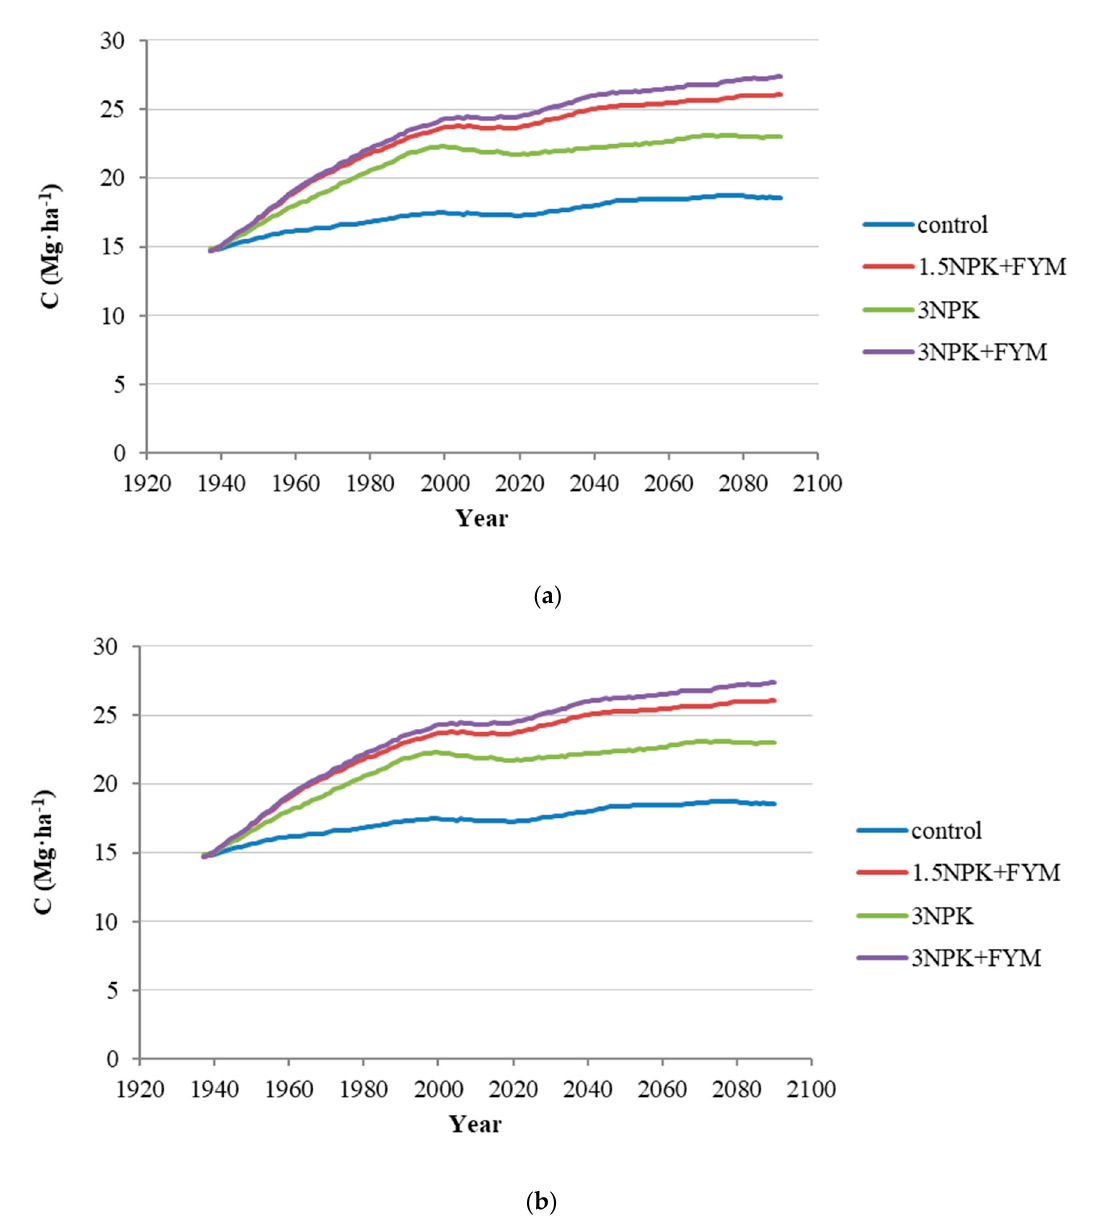
Figure 6. Simulated annual dynamics of C in the HUM pool in the DAOS 4 experiment: ( a ) RCP4.5 and ( b ) RCP8.5.